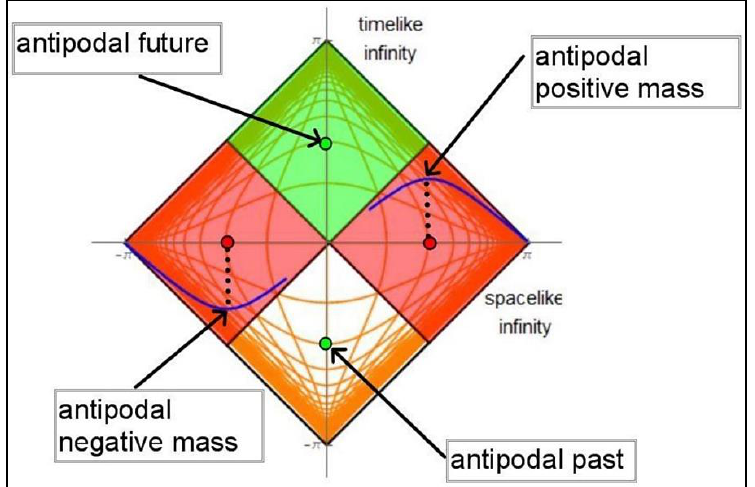
Figure 3 . Evolution of chunks of soft matter in the neighborhood of a black hole. Antipodal spacetime is represented with a Penrose diagram, which also mimics the behavior of matter in the neighborhood of a black hole. Vertically, the green region represents future time and the orange region represents past time in the lifespan of a chuck of matter. Horizontally, the concave down blue geodesic line in the red region +𝝅 represents the positive mass of a chuck matter on the S 4 surface of a black hole, whereas the concave up blue geodesic line in the red region –𝝅 represents the negative mass of a chunk of matter on the opposite